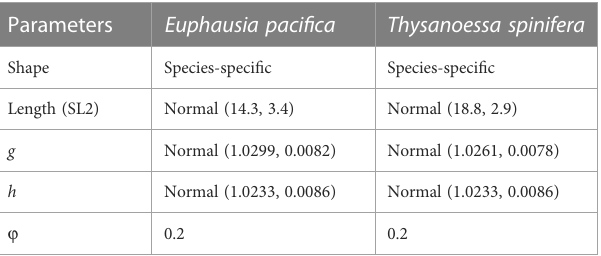
TABLE 1 Summary of SDWBA model inputs for each krill species with distributions (Gaussian, mean value ± standard deviation) reported where